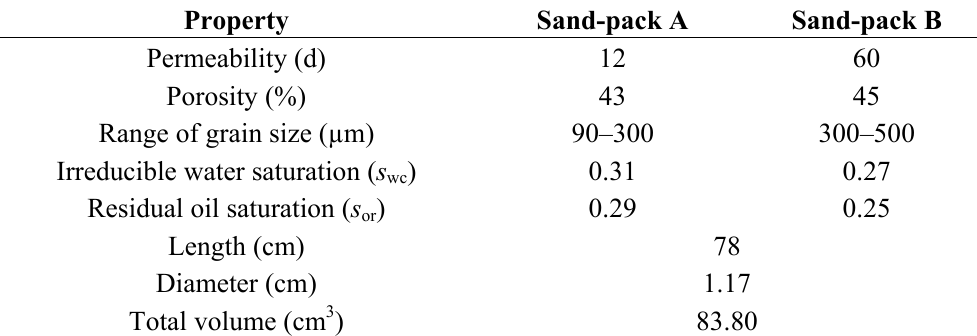
Table 3. Physical properties of the two sand-packs used in the flooding